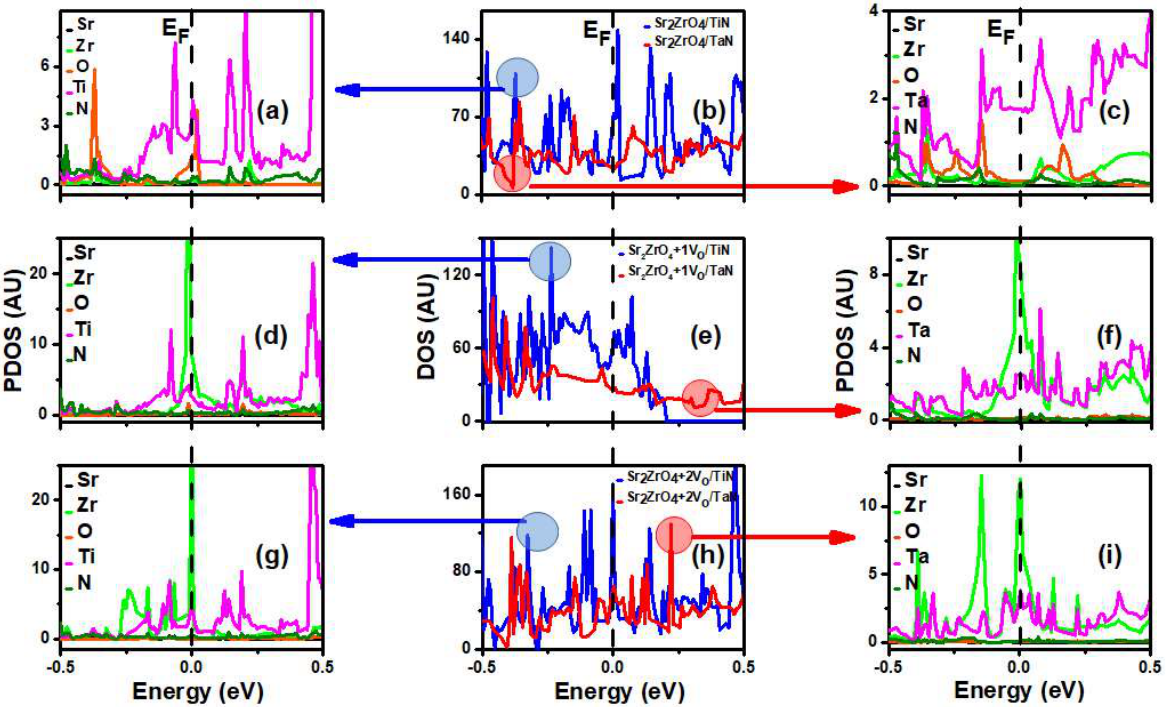
Figure 7. DOS in middle panel and their respective PDOS in left and right panel for ( a – c ) pristine ( d – f ) pristine + 1V o ( g – i ) pristine + 2V o 2D layered RP perovskite structures.